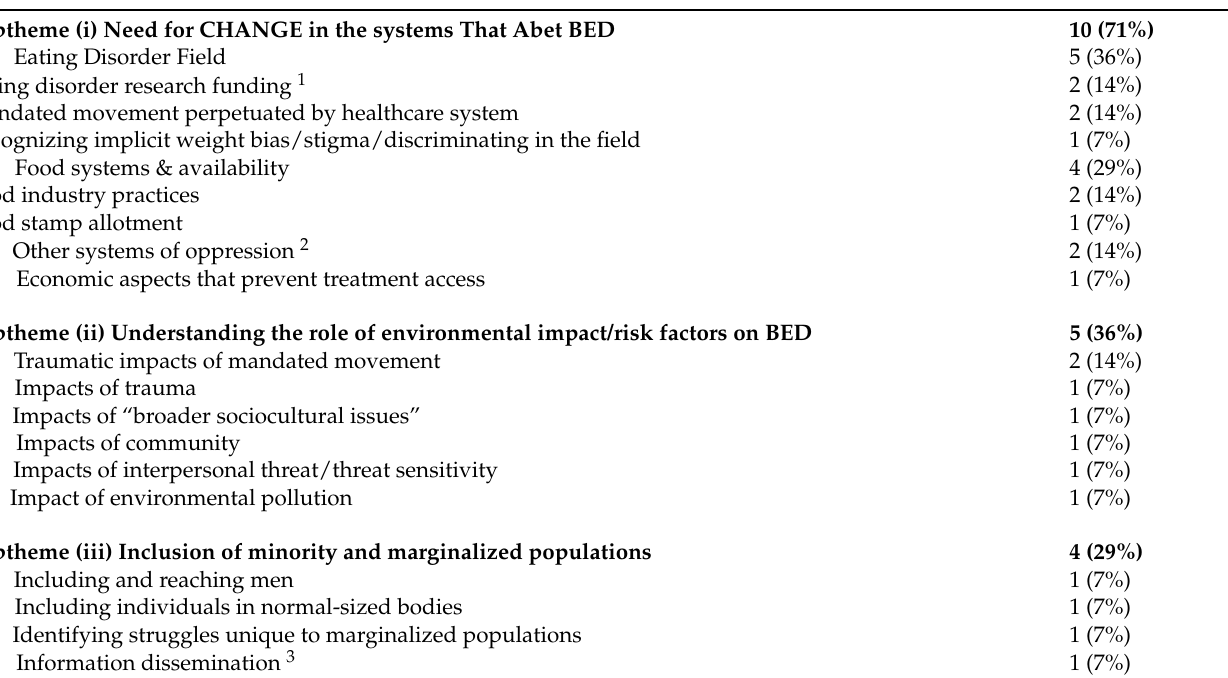
Table 12. Participant statements related to theme 9, “research gaps and future